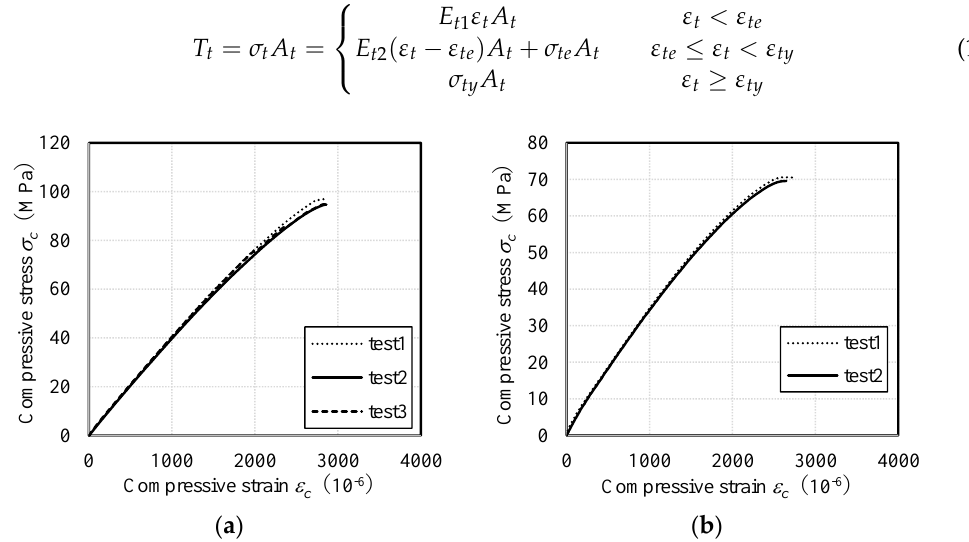
Figure 4. Compressive stress − strain relations of concrete by material tests: ( a ) PCX01; ( b ) PCJ06.